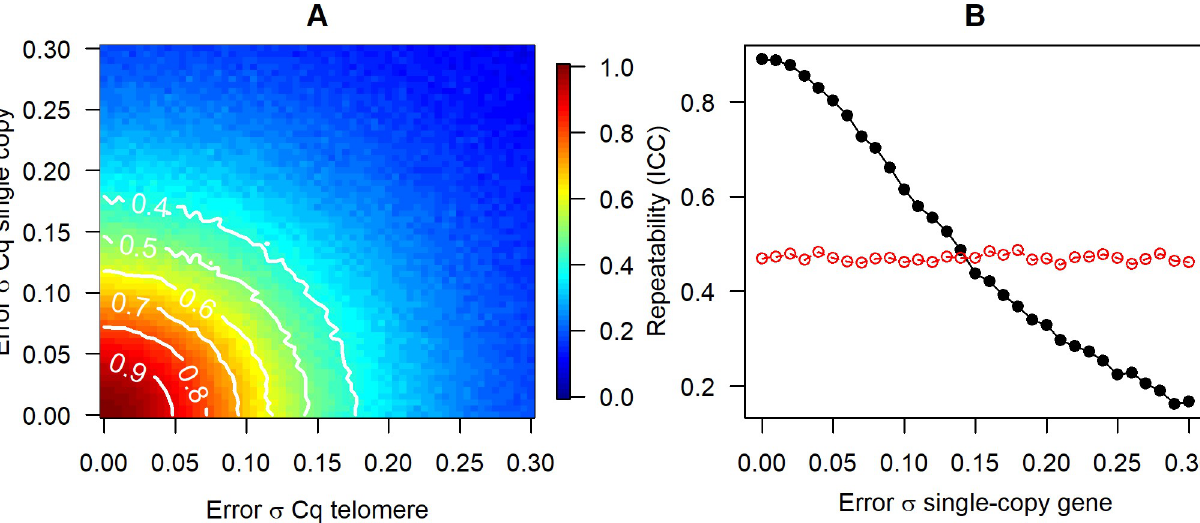
Fig 4. Effects of measurement error on repeatability of the measured TS ratio. A. Repeatability (intra-class correlation coefficient) of the TS ratio as measurement error in the two Cq values varies. B. Repeatability of the measured TS ratio (black line, filled circles) and the measured telomere Cq (red circles), as measurement error in the single-copy gene increases. The error σ for telomere is fixed at 0.05. The point where the two lines cross is the point where the advantage of controlling for sample-to-sample variation in the amount of DNA present is offset by the extra measurement error introduced.